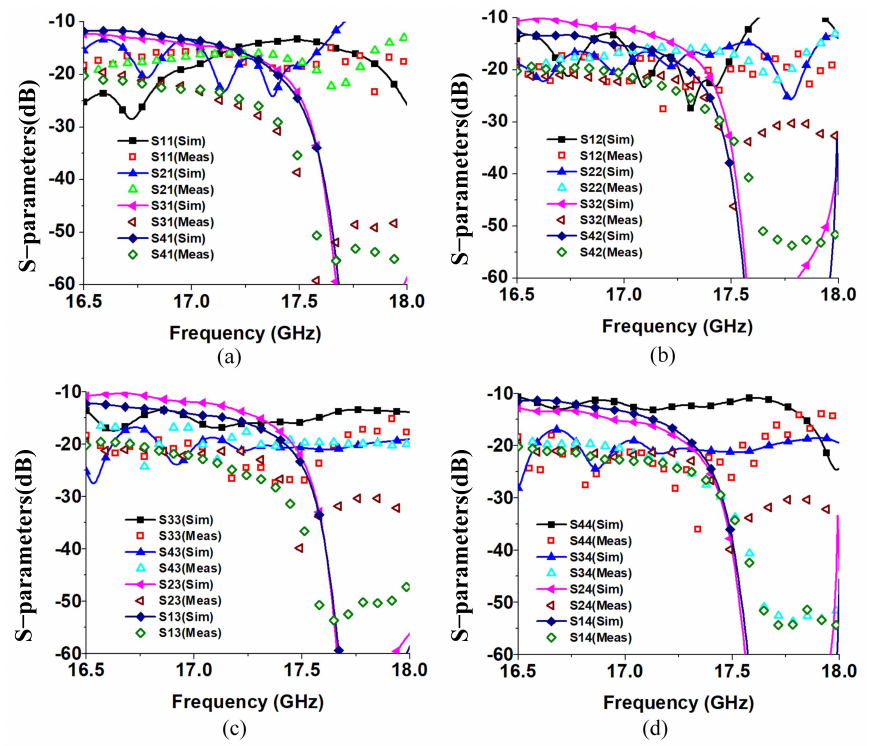
Figure 15. Measured and simulated scattering parameters of the proposed antenna when excited at ( a ) Port 1, ( b ) Port 2, ( c ) Port 3, and ( d ) Port 4, respectively. The proposed antenna with polarization flexibility and frequency scanning was mea- sured in an anechoic chamber using the setup shown in Figure 16. A standard gain LP horn antenna as the transmitter was rotated at a given angle by varying the polarization modes. The standard gain antenna was measured first for calibration. The measured antenna as a receiver was rotated from − 180 ◦ to 180 ◦ , and the receiving power level was detected and recorded at the corresponding port.